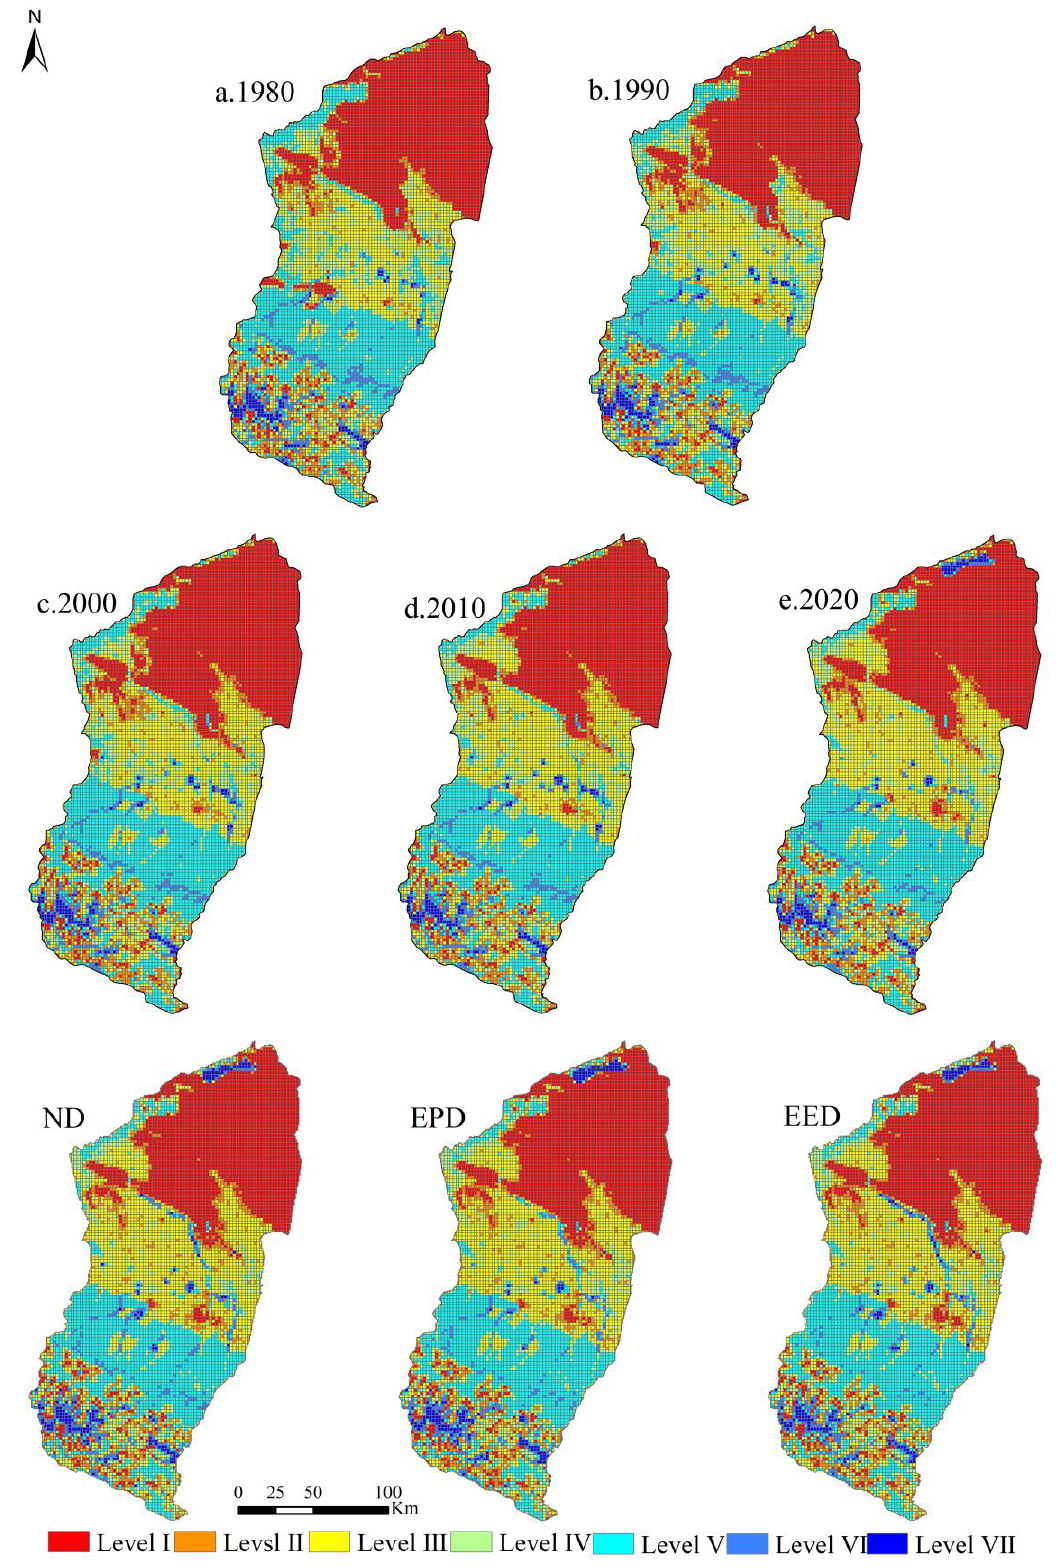
Figure 8. Temporal and spatial variations in the ESV in the Manas River Basin from 1980 to 2030.